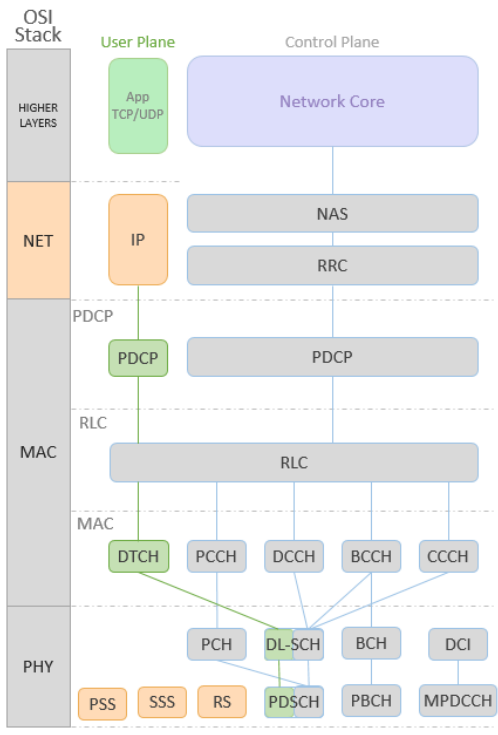
Figure 20. LTE-eMTC downlink